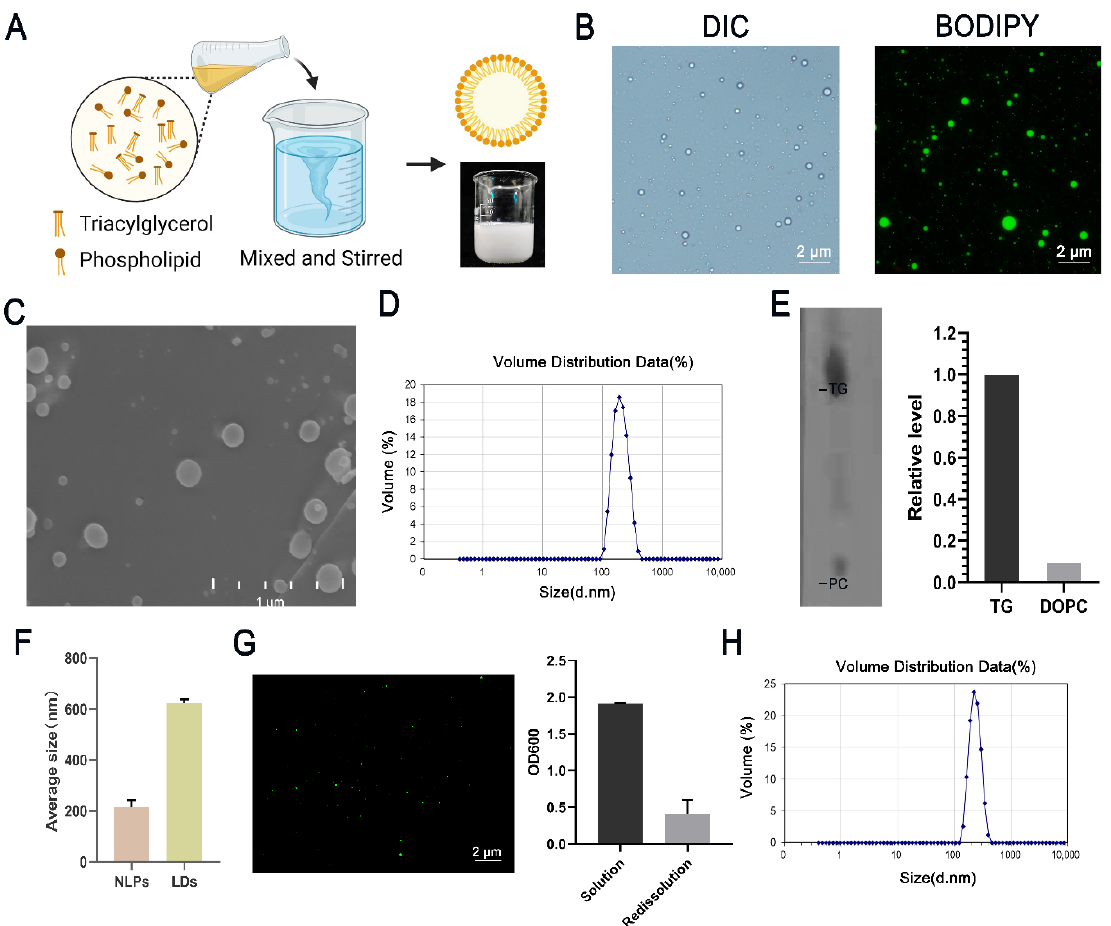
Figure 1. Preparation of NLPs and their properties. ( A ) Flow chart for the preparation of NLPs. Briefly, we used ethanol as a solvent to dissolve phospholipids and triglycerides by heating, added the organic phase to aqueous buffer, and stirred until the ethanol evaporated completely to form a solution of NLPs, which was a milky white liquid. The lower right side shows a picture after preparation. ( B ) DIC and fluorescence microscopy imaging of NLPs and BODIPY staining. Scale bars, 2 µ m. ( C ) SEM imaging of NLPs. Scale bars, 1 µ m. ( D ) Particle size distribution of NLPs. The average particle size was 215.3 nm. ( E ) TLC analysis of the DOPC/total lipids ratio of NLPs. The grayscale was analyzed by ImageJ. DOPC accounted for 8.5% of the total lipids, indicating the presence of a monolayer phospholipid structure on the NLPs. ( F ) HepG2 cells were treated with oleic acid, and LDs were extracted to measure their particle size compared to that of NLPs. The average size of HepG2 cell LDs was 623 ± 139.4 nm, and that of NLPs was 215.3 nm. n = 3, average ± SD. ( G ) The lyophilized powder of NLPs was redissolved in 4 mL of 0.2% Tween 80 solution, and the upper white lipid droplet band was collected after one centrifugation and then stained with BODIPY493/503 for observation. The optical density was measured. ( H ) Particle size distribution after rehydration of the freeze-dried powder. The average particle size was 233.5 ± 53.19